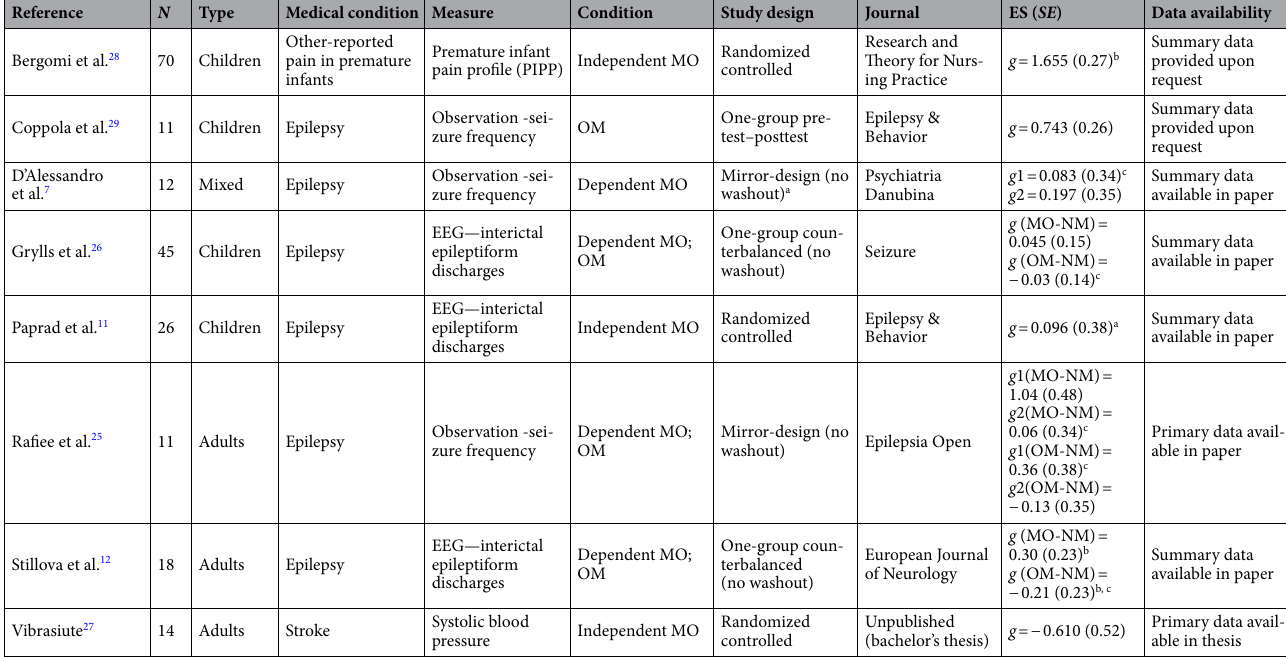
Table 2. Study characteristics of included studies. N = sample size; ES = Effect size; SE = standard error; Independent MO = independent-groups pretest–posttest designs examining KV448 versus silence;